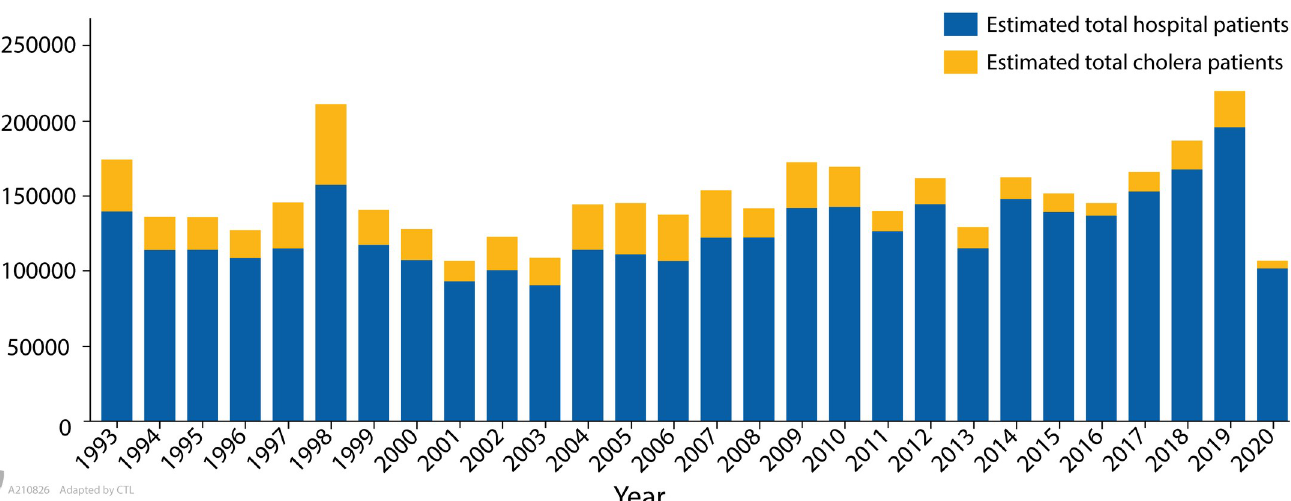
in 2009, the isolates that appeared were resistant to erythromycin during the following years. The susceptibility of V . cholerae O139 to ciprofloxacin and azithromycin was high, with some exceptions as shown on Table 5.